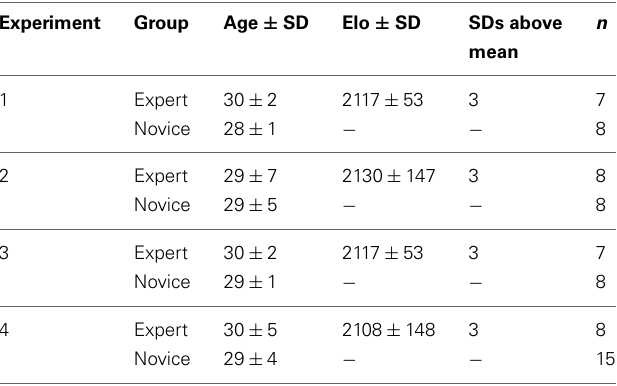
Table 1 | Participants in the studies of Bilali´c et al. (2010, 2011a,b, 2012): group, mean age, mean skill level as measured by the Elo rating (see Methods) with standard deviation (SD), number